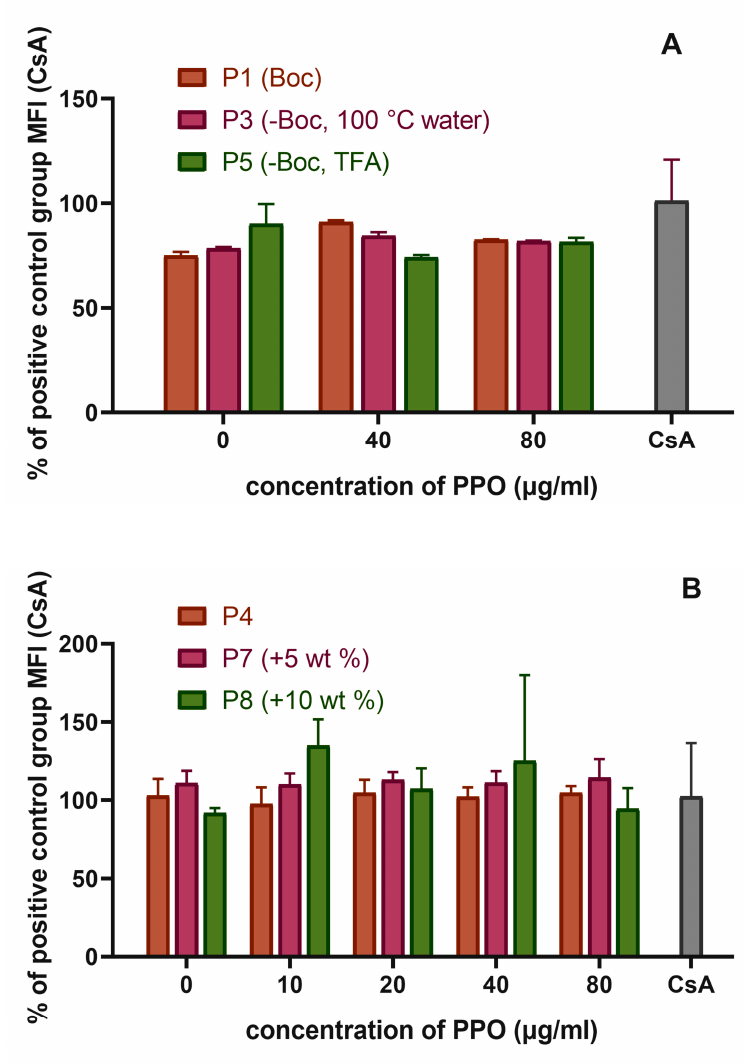
Figure A1. The activity of block copolymer carriers in sensitive P388 cells determined by calcein efflux assay. ( A ) The effect of Boc-protected or -deprotected copolymers on P-gp inhibition after 24 h of; 10 µM cyclosporine A as the positive control. ( B ) The effect of PHPMA-PPO copolymers with loaded free PPO.